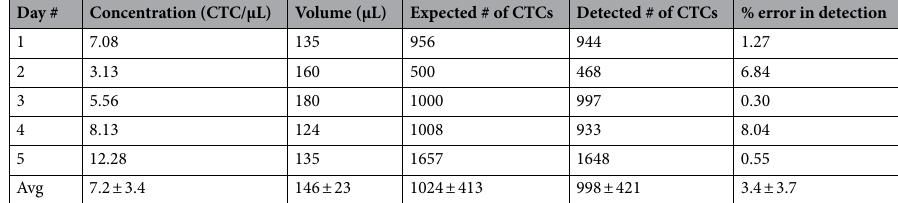
Table 1. Detection of GFP-associated CTCs in whole blood by the BSFC (± standard deviation).